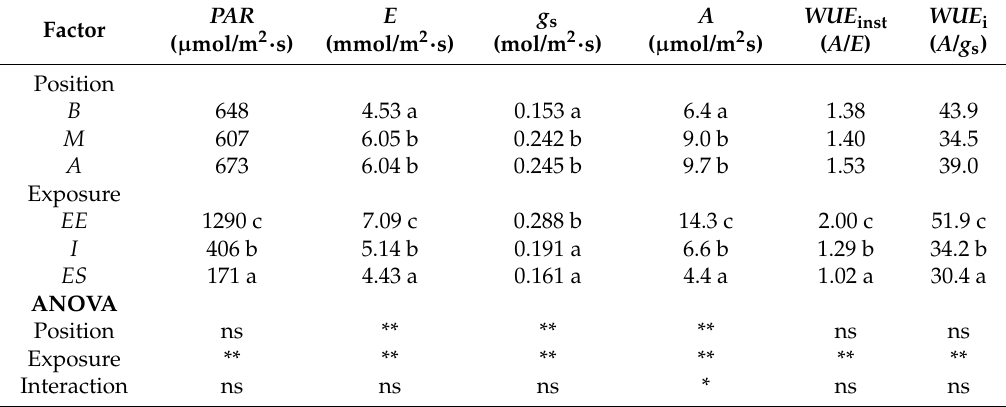
Table 5. Effect of leaf position ( B , M , A ) and exposure ( EE , I , ES ) on leaf gas exchange and water use efficiency. Data taken on 6 July. B = basal; M = median; A = apical. EE = exterior/exposed; I = interior; ES = exterior shaded.